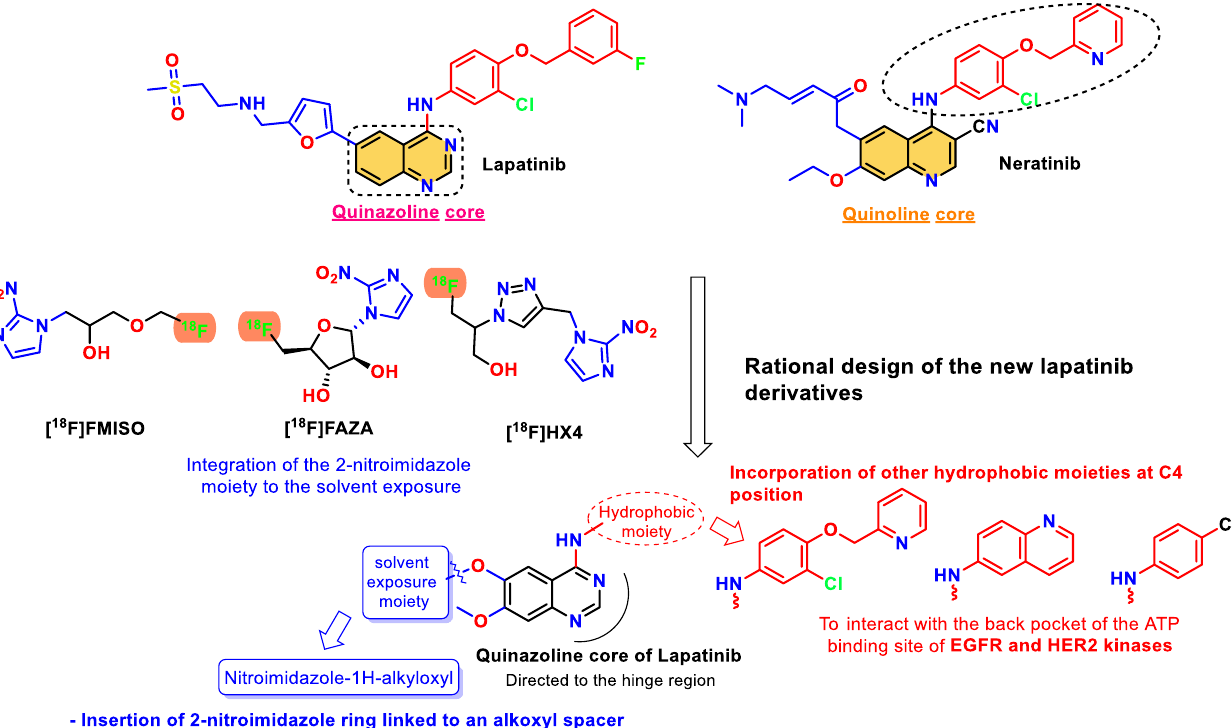
Figure 2. Design of the new lapatinib derivatives 6a – l.